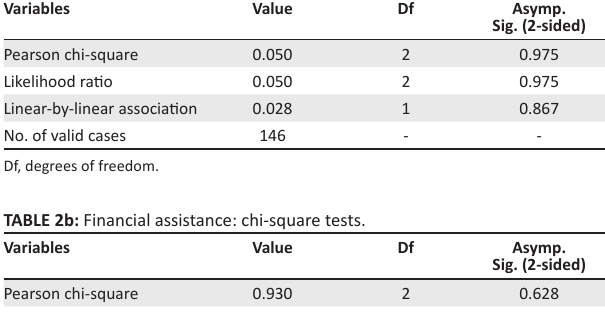
TABLE 1a: Chi-square tests: Export experience and supplies and markets. Variables